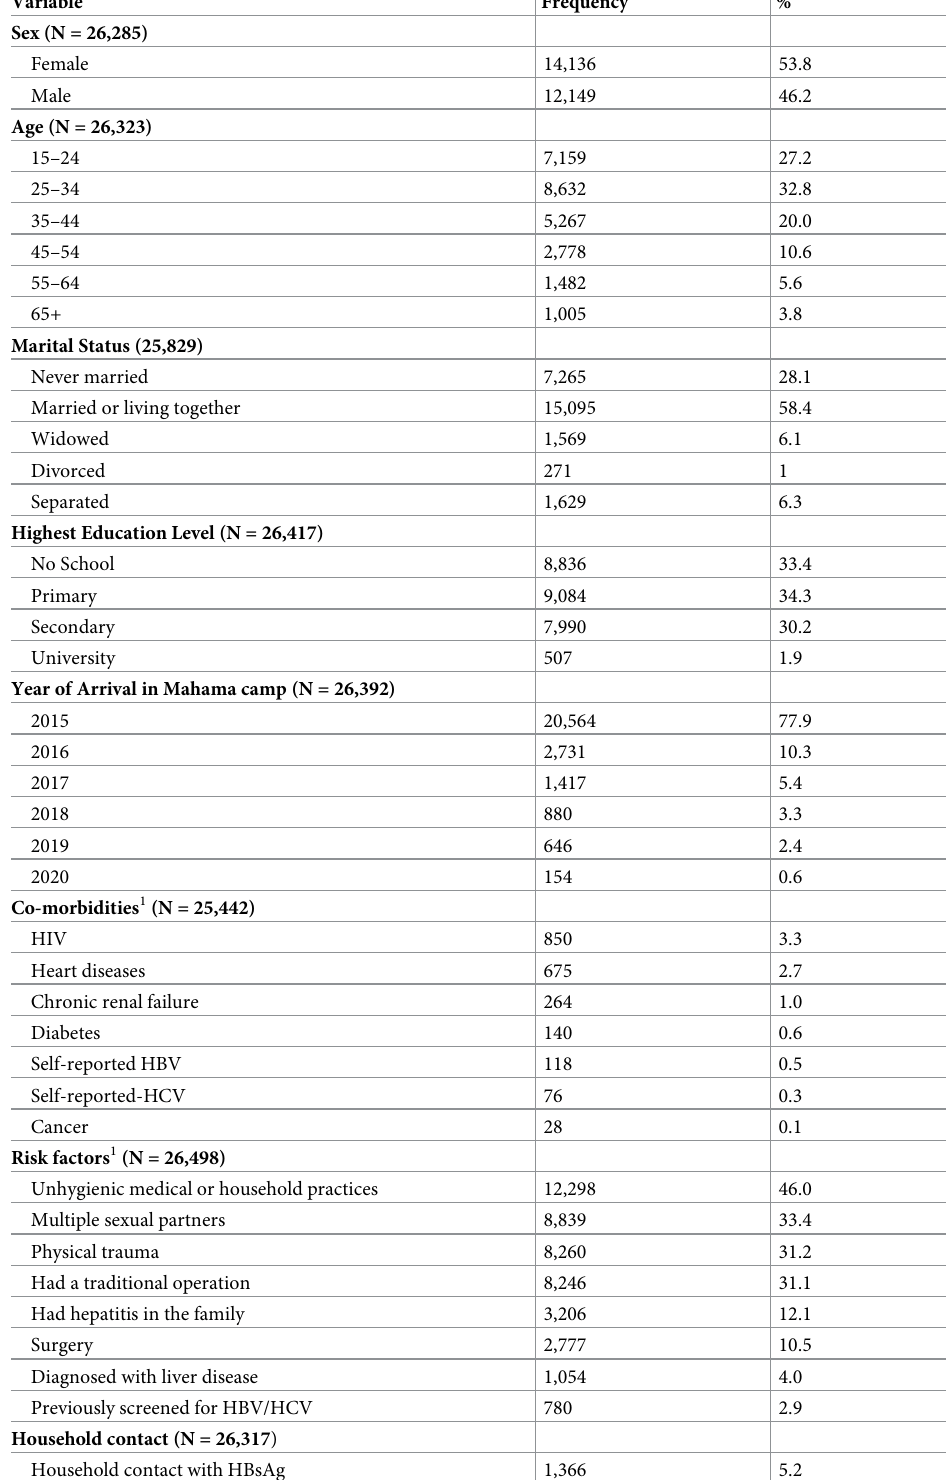
Table 1. Sociodemographic and self-reported clinical